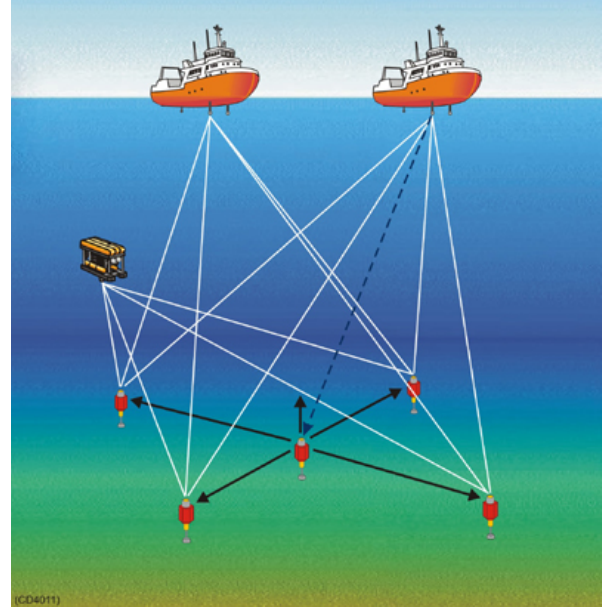
Figure 5: Long baseline acoustic navigation network. Image courtesy of Kongsberg Maritime